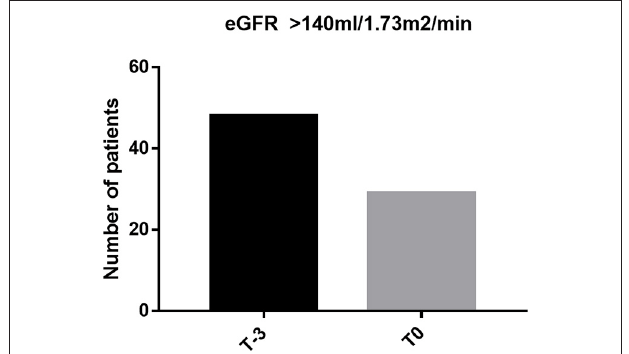
FIGURE 1 | Proportion of glomerular hyperfiltration at last clinic visit (T 0 ) and at 3 years before the last encounter (T − 3